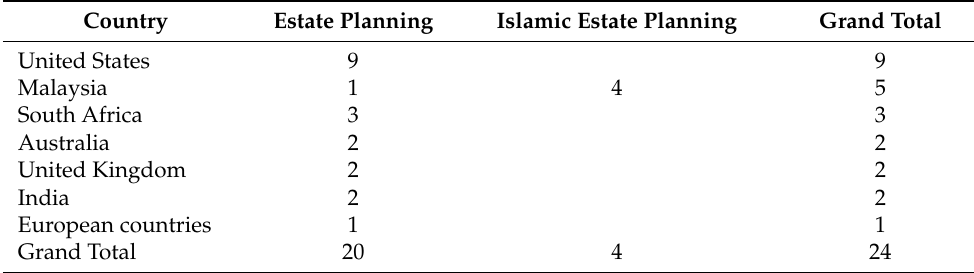
Table 5. Frequency table on country where the selected studies conducted. Country Estate Planning Islamic Estate Planning Grand Total United States 9 9 1 4